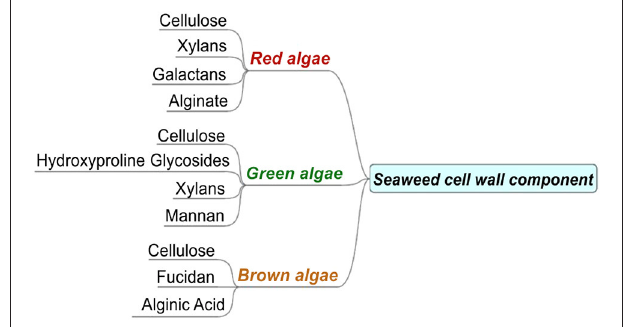
FIGURE 1 | Major chemical constituents of the seaweed cell wall, adapted from Bold and Wynne (1984).